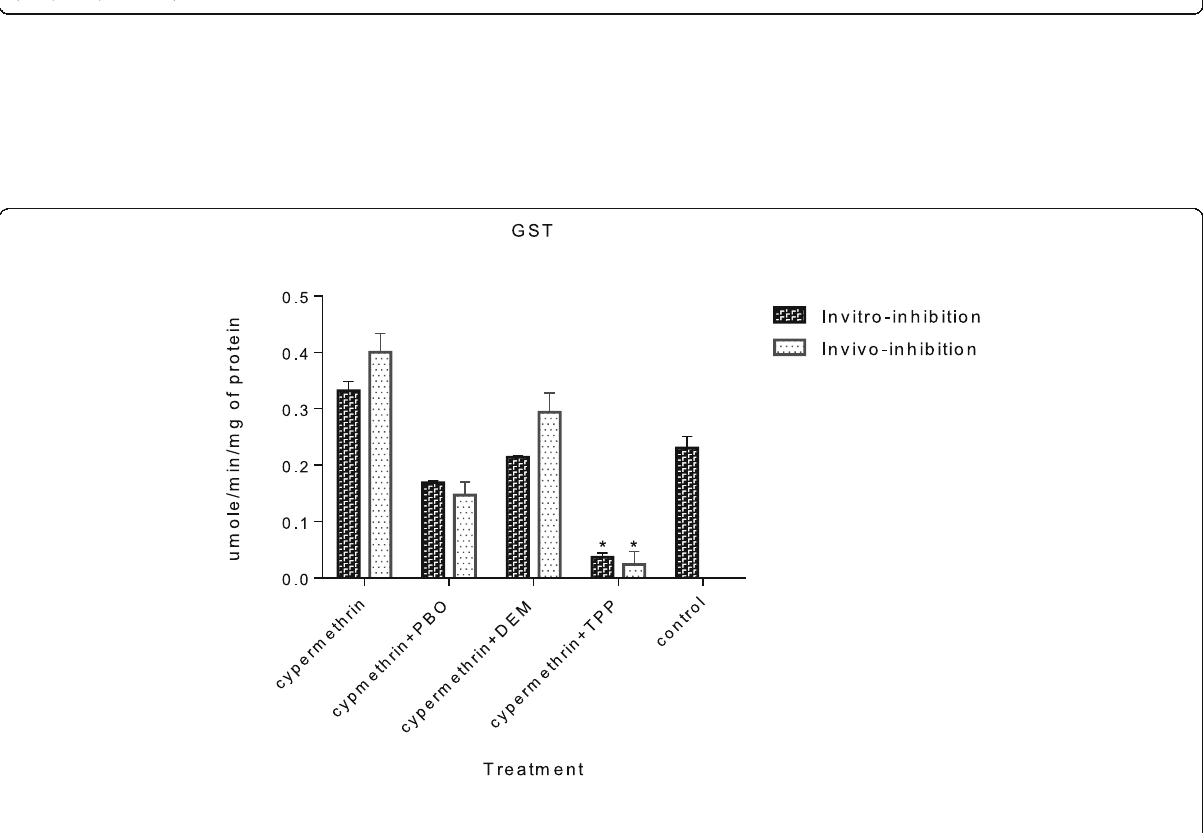
Fig. 4 The in vitro and in vivo inhibition of fourth instar larvae Amsacta albistriga glutathione-S-transferase activity with and without enzyme inhibitor (PBO, DEM, and TPP). Legend: * indicates significant value P < 0.01 (Tukey ’ s multiple comparison